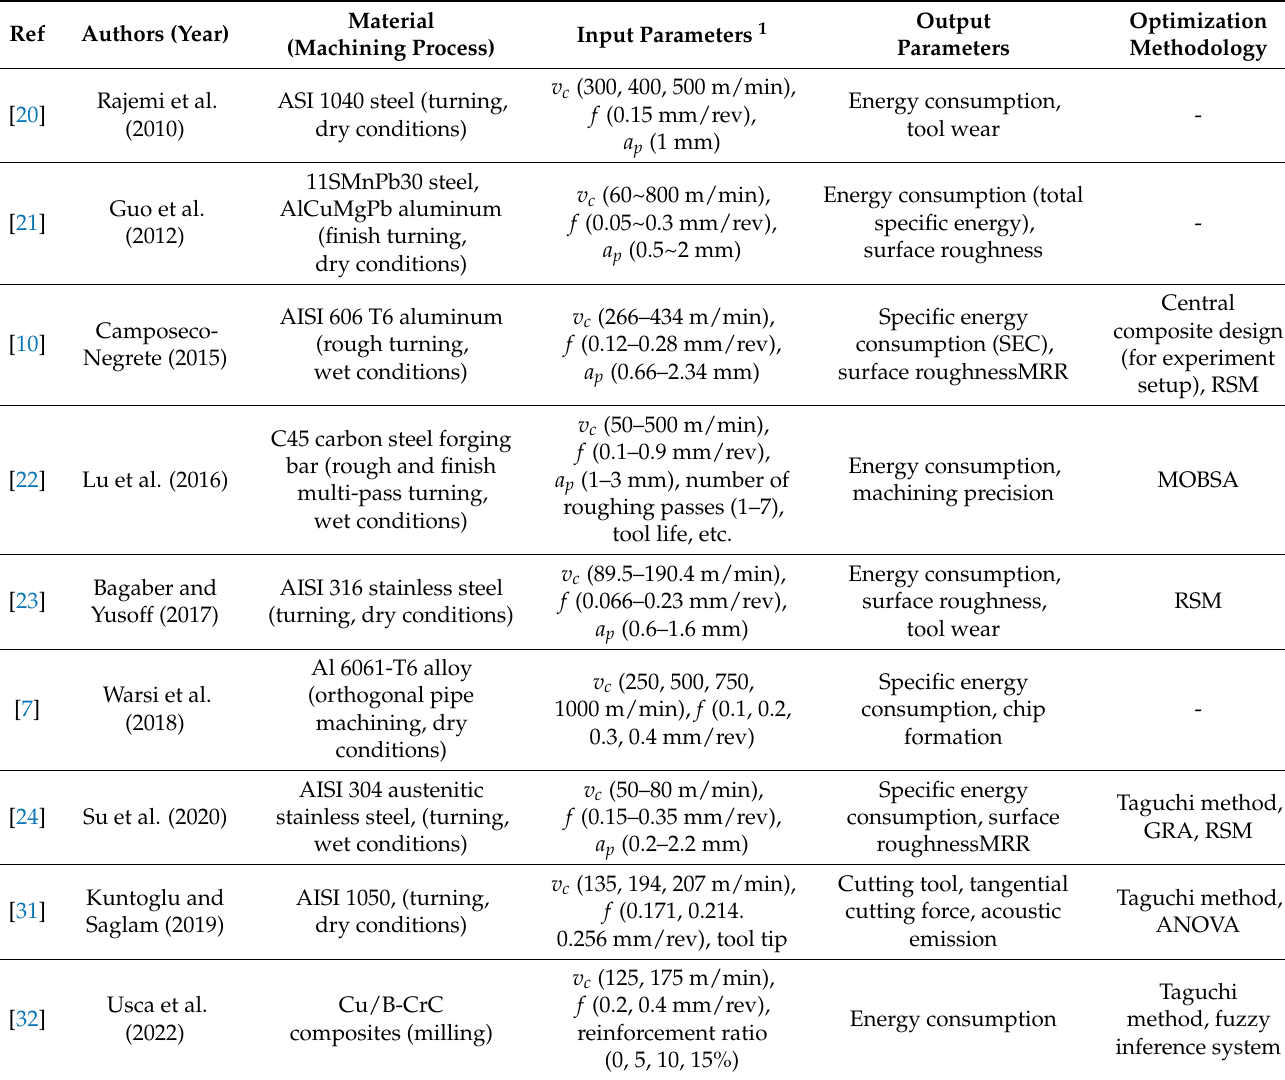
Table 1. Summary of work related to parameter